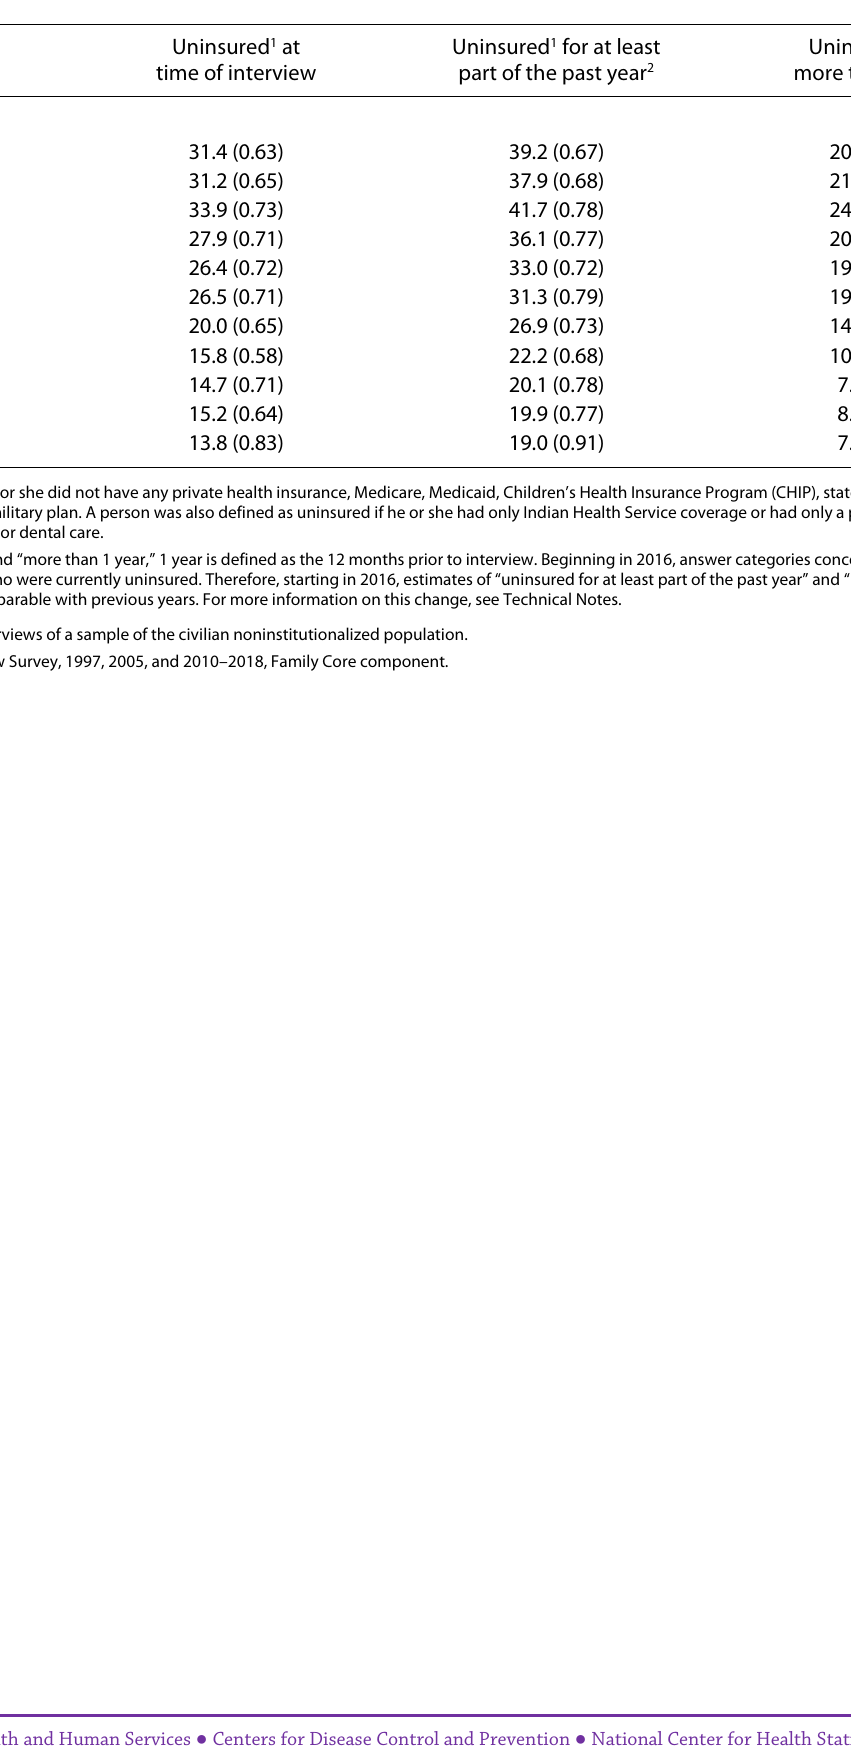
Table I. Percentages (and standard errors) of persons who lacked health insurance coverage at the time of interview, for at least part of the past year, and for more than 1 year, by age group and selected years: United States, 1997–June